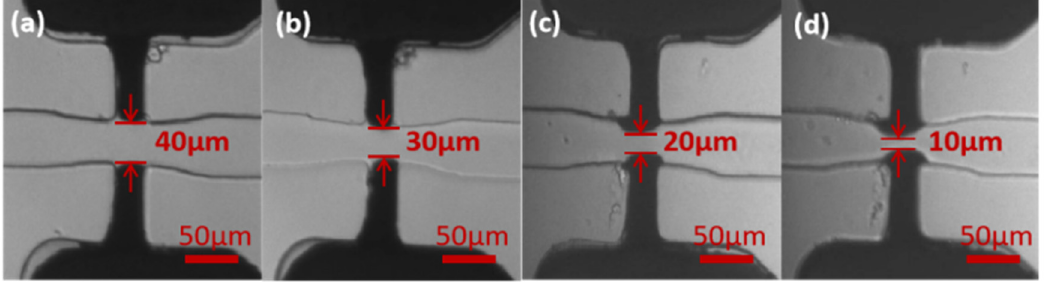
Figure 6. The fabrication of microelectrodes with different microdistances: ( a ) 40 μ m spacing; ( b ) 30 μ m spacing; ( c ) 20 μ m spacing; ( d ) 10 μ m spacing.